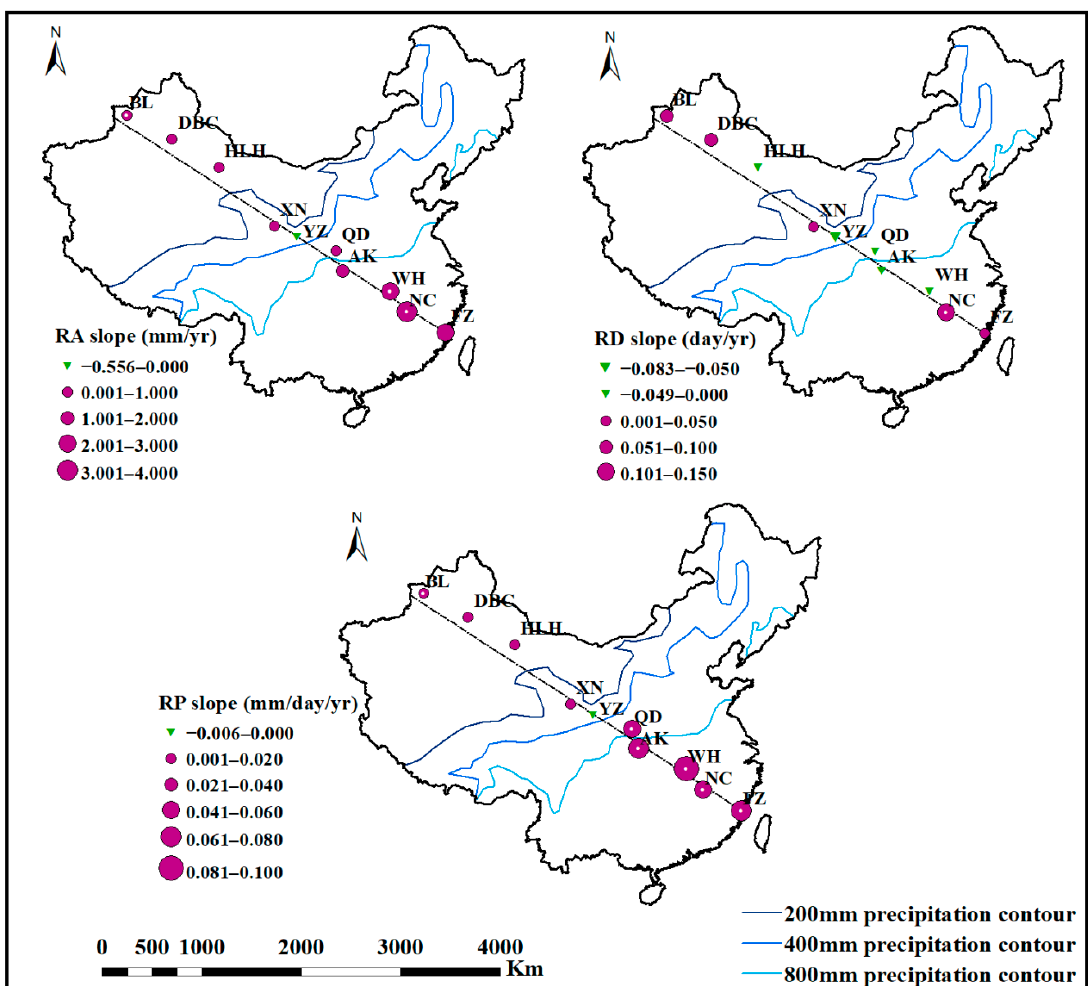
Figure 4. The Mann-Kendall trend test and Sen’s slope were used to reflect the variation trends for the summer precipitation indices, including rainfall amount (RA), rainfall days (RD), and daily precipitation on rainy days (RP). Note: white spots mean precipitation change trend reached the significance level of 95% confidence for the MK trend test.